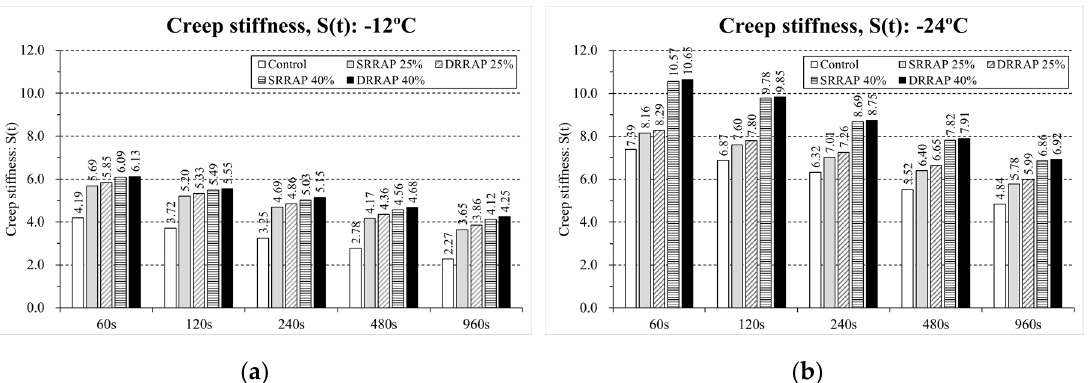
Figure 5. Creep stiffness, S ( t ), at different testing time. ( a ) T = − 12 °C; ( b ) T = − 24 °C. Figure 5. Creep sti ff ness, S ( t ), at di ff erent testing time. ( a ) T = − 12 ◦ C; ( b ) T = − 24 ◦